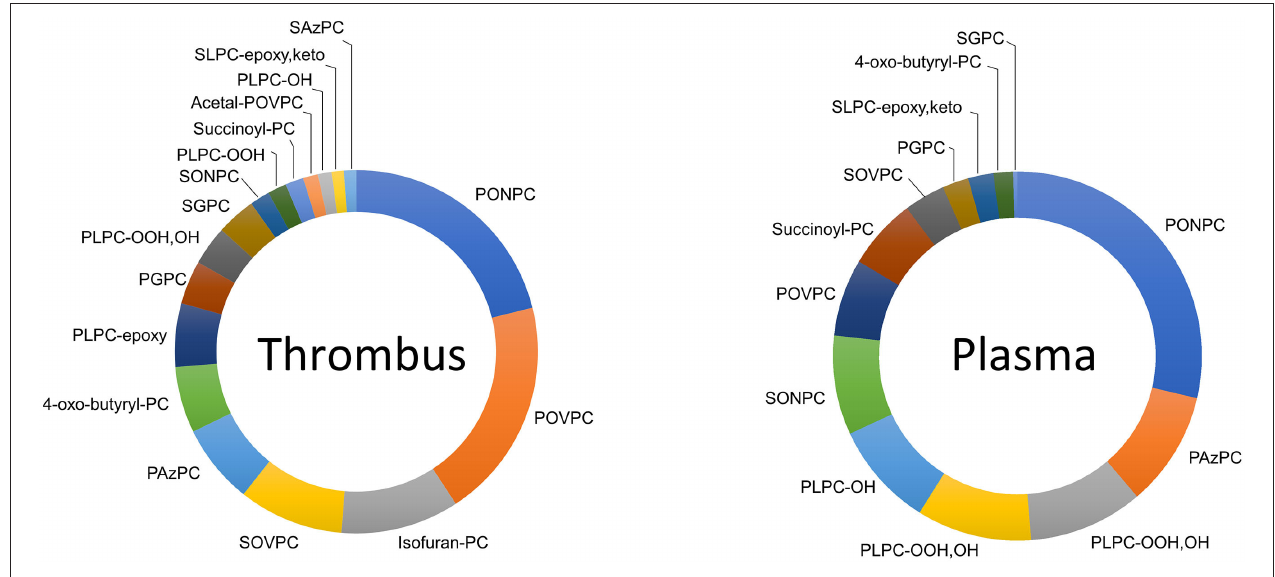
FIGURE 9 | Ten most abundant OxPCs in thrombus and plasma of STEMI patients during